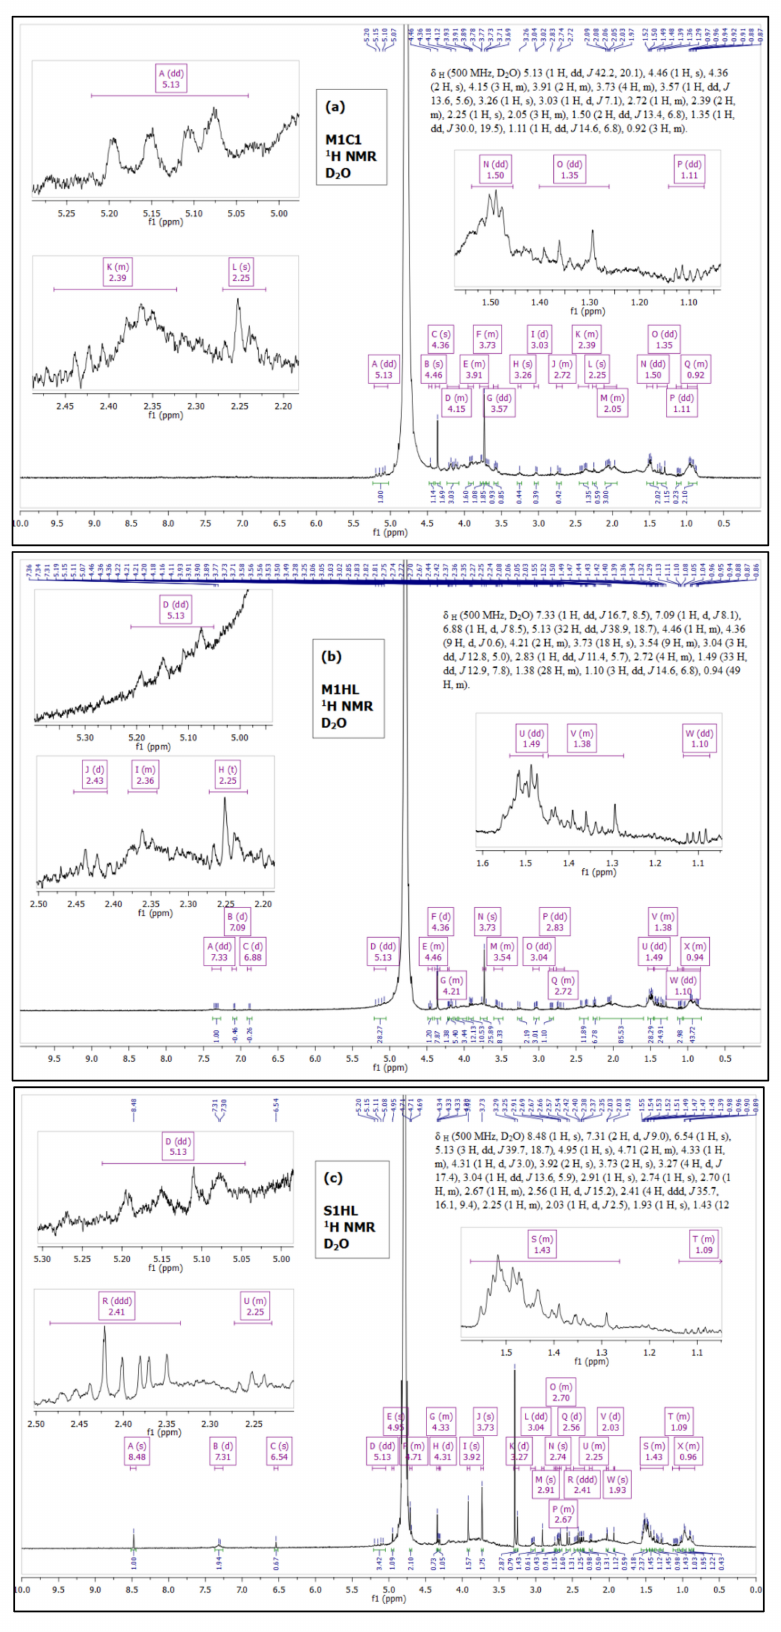
Figure 1. 1 H NMR spectra of BSs produced by C1 and HL strains of Trichoderma citrinoviride on the M1 ( a , b ) and S1 ( c )